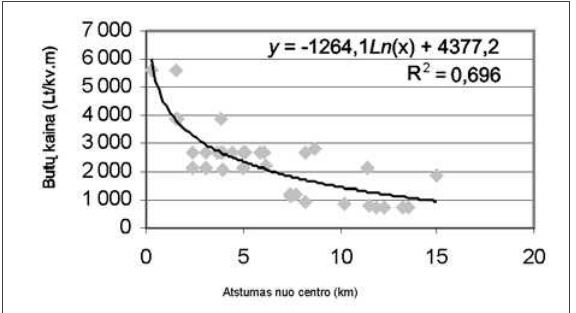
Fig 4. Logarithmic model gives the best evaluation of dwelling price changes with receding from city